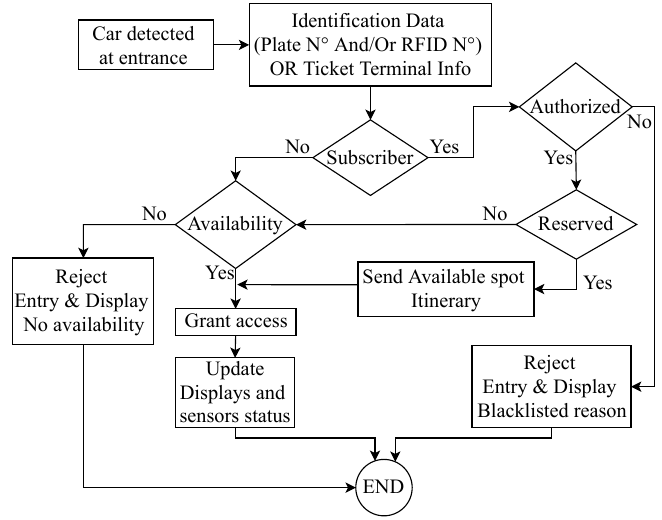
Figure 4. The parking entrance